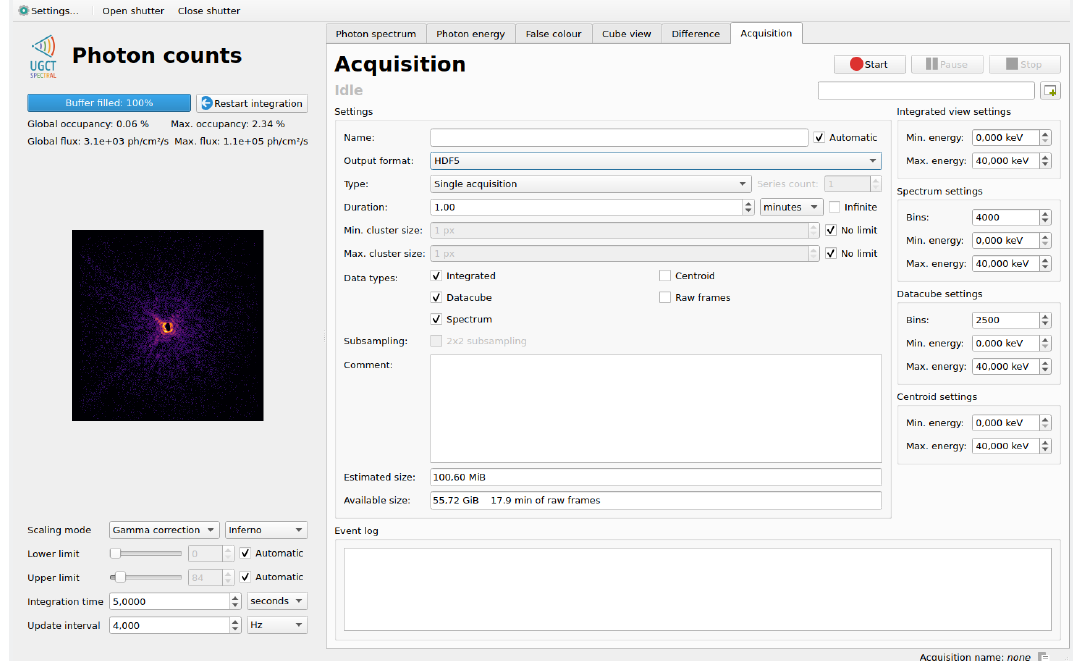
Figure 6. The measurement control section of the main user interface. Through this interface the operator configures and starts the controlled measurements which are sent to storage, and which run completely independently of all other viewing features of the